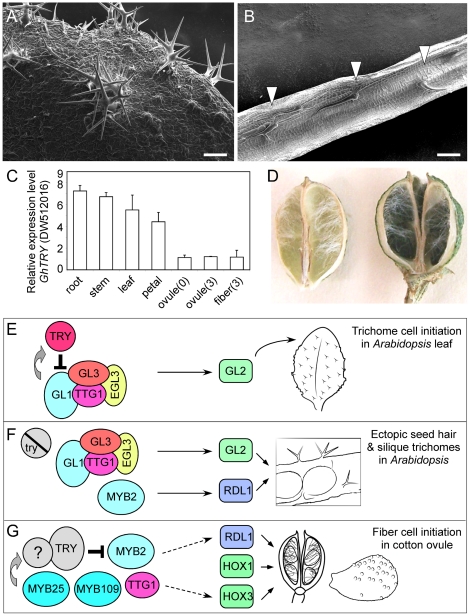
Trichome production inside siliques and cotton bolls.(A) An SEM image showing clustered silique trichomes in try transgenic plants overexpressing GhRDL1 and GhMYB2. (B) An SEM image of branched and unbranched trichomes inside siliques of the transgenic plants. Scale bars in (A and B) represent 100 µm. (C) qRT-PCR analysis of a putative cotton cpc gene (DW512016) in cotton tissues (n = 3). (D) Unbranched trichomes (white) produced inside cotton bolls. (E) A model of leaf trichome development. (F) A model of ectopic trichome production in Arabidopsis silique and seed coat. (G) A model of seed hair production in cotton. See text for detailed explanations.